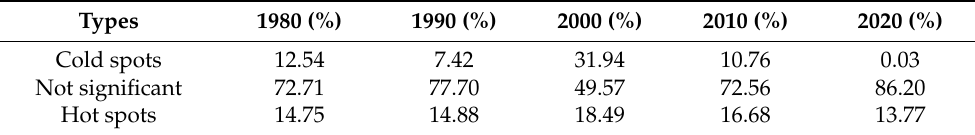
Figure 8. Spatial distributions of SCS hot and cold spots. Table 2. Proportions of cold spots, hot spots, and non-significant regions from 1980 to